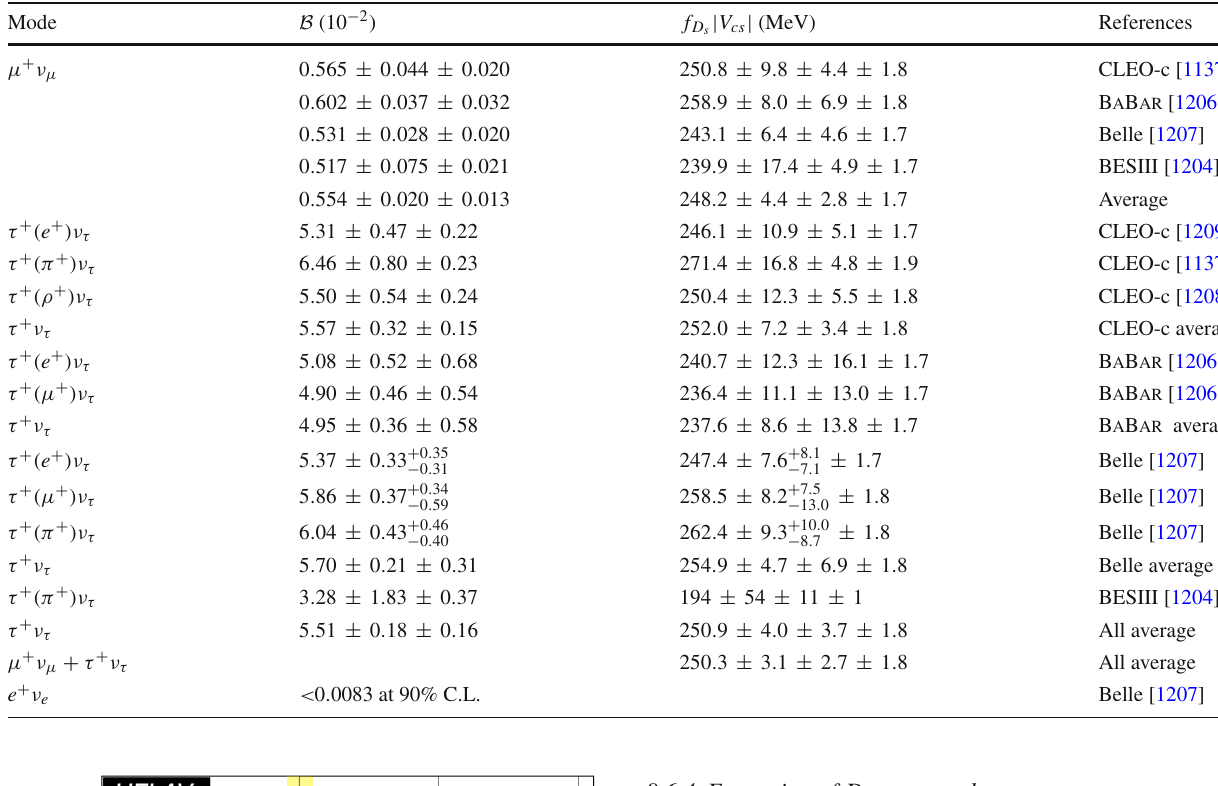
Table 283 Experimental results and world averages for B ( D + s → (cid:12) + ν (cid:12) ) and f | V | . The first uncertainty is statistical and the second is D s cs experimental systematic. The third uncertainty in the case of f D is due to external inputs (dominated by the uncertainty of τ D recalculated B ( D + s → τ + ν τ ) quoted by CLEO-c and BaBar using the latest values for branching fractions of τ decays to electron, muon, or